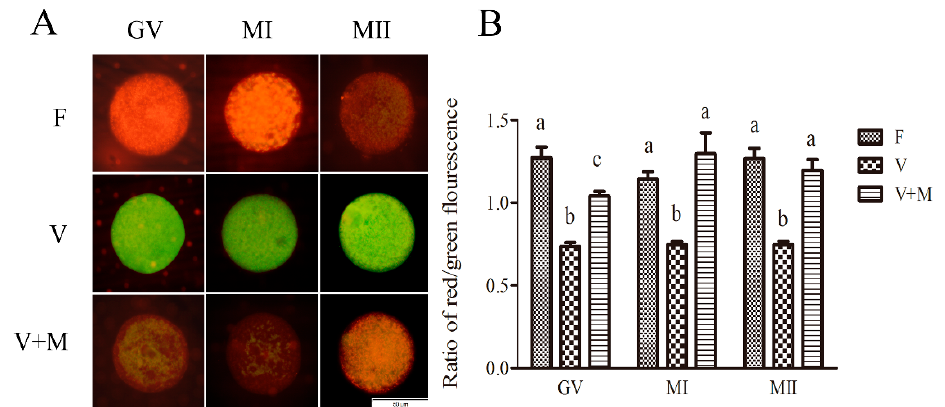
Figure 3. E ff ects of melatonin (MT) on mitochondrial membrane potential in vitrified-warmed mouse GV oocytes during in vitro maturation. ( A ): Representative fluorescence images depicting the mitochondrial membrane potential levels in vitrified-warmed mouse oocytes at di ff erent stages of development (GV, MI, and MII); (oocytes stained with JC-1). Fresh control (F), vitrification (V), and vitrification + MT (V + M). Scale bar = 50 µ m. ( B ): Mitochondrial membrane potential levels in vitrified-warmed mouse oocytes. Fluorescence intensities were measured using ImageJ software. In total, n = 348 GV oocytes were used in this assay (F: n = 104; V: n = 138; V + M: n = 106). Data are presented as mean ± SEM of three independent experiments. Di ff erent superscripts (a, b, and c) indicate significant di ff erence ( p < 0.05) between groups at the same time point (at corresponding developmental